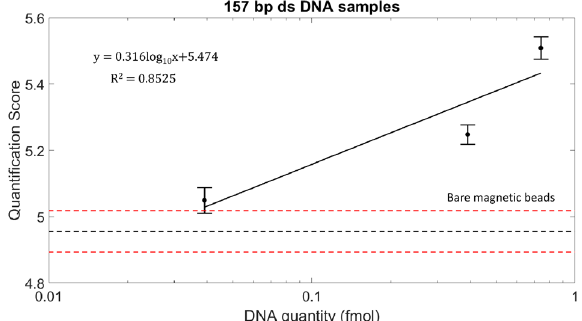
Figure 3. Effect of 157 bp ds DNA concentration on impedance response. The experiment on 157 bp ds DNA samples showed a similar trend with the impedance change directly related to increasing DNA amounts (Table 1). The impedance information from all 8 frequencies was converted into a quantification score used to plot the graph. Linear correlations between quantification score and the logarithm of 157 bp DNA fragments attached to the beads were calculated. Error bars represent standard error of mean. Horizontal black and red dotted lines represent the average quantification score of the negative control samples and negative control ± standard error,